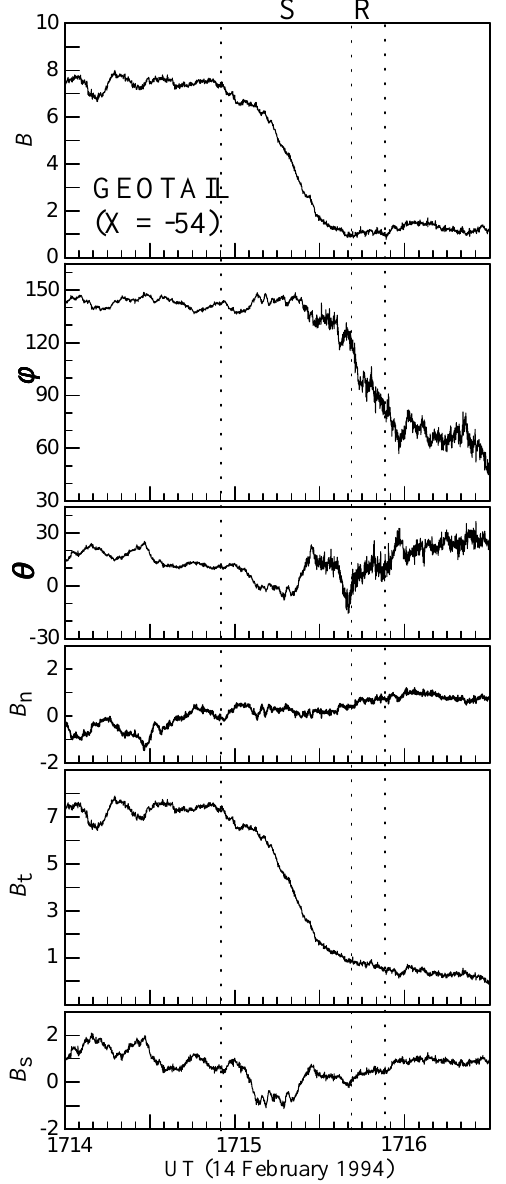
Fig. 1. The observed double discontinuity of 14 February 1994 composed of a slow shock (S-layer) and an adjoining rotational dis- continuity (R-layer). The decrease in the magnetic field intensity occurs primarily inside the S-layer. Through the R-layer, the di- rection of the magnetic field makes a significant change, while its magnitude remains almost constant.